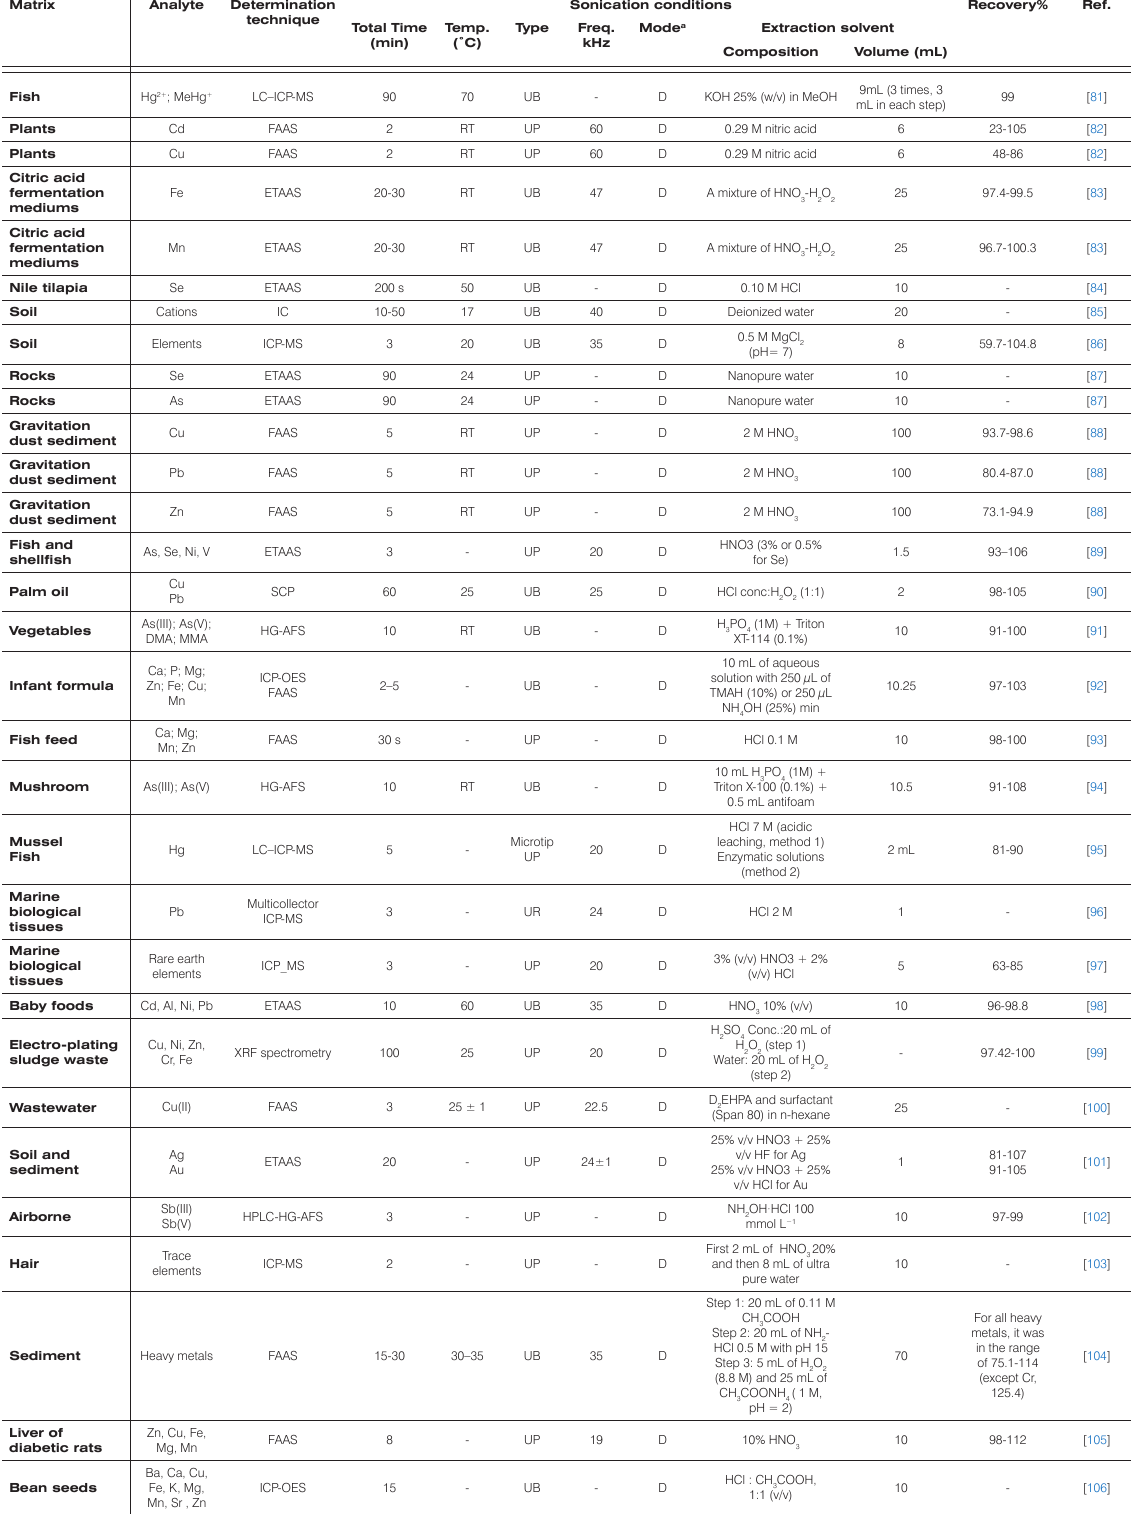
Table 3. Different ultrasound assisted extraction techniques for determination of metal elements from different matrices.